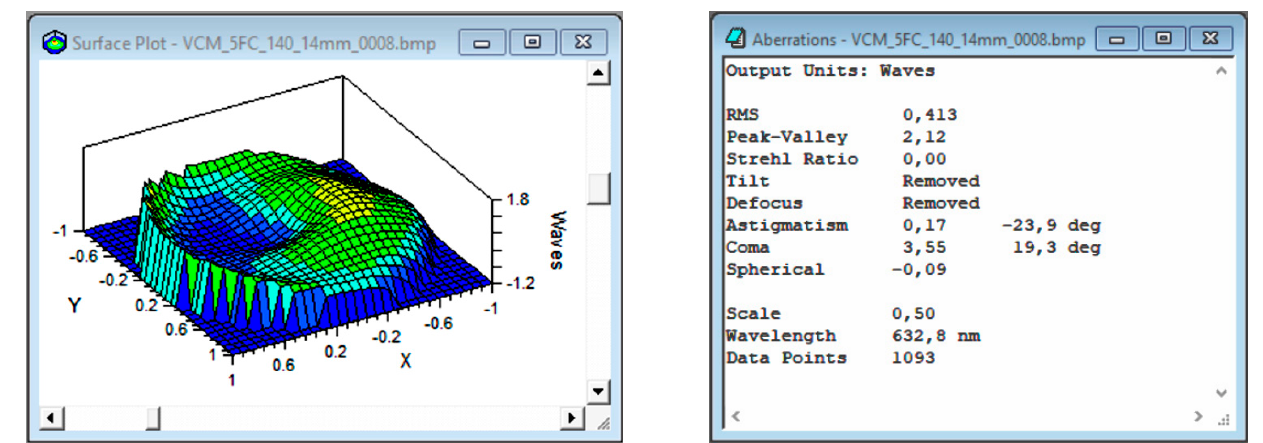
Figure 18. Surface plot ( left ) and aberration table ( right ) of VCM#5 at full clear aperture 14 mm for the maximum curvature deformation at f /5, corresponding to a curvature radius 140 mm.